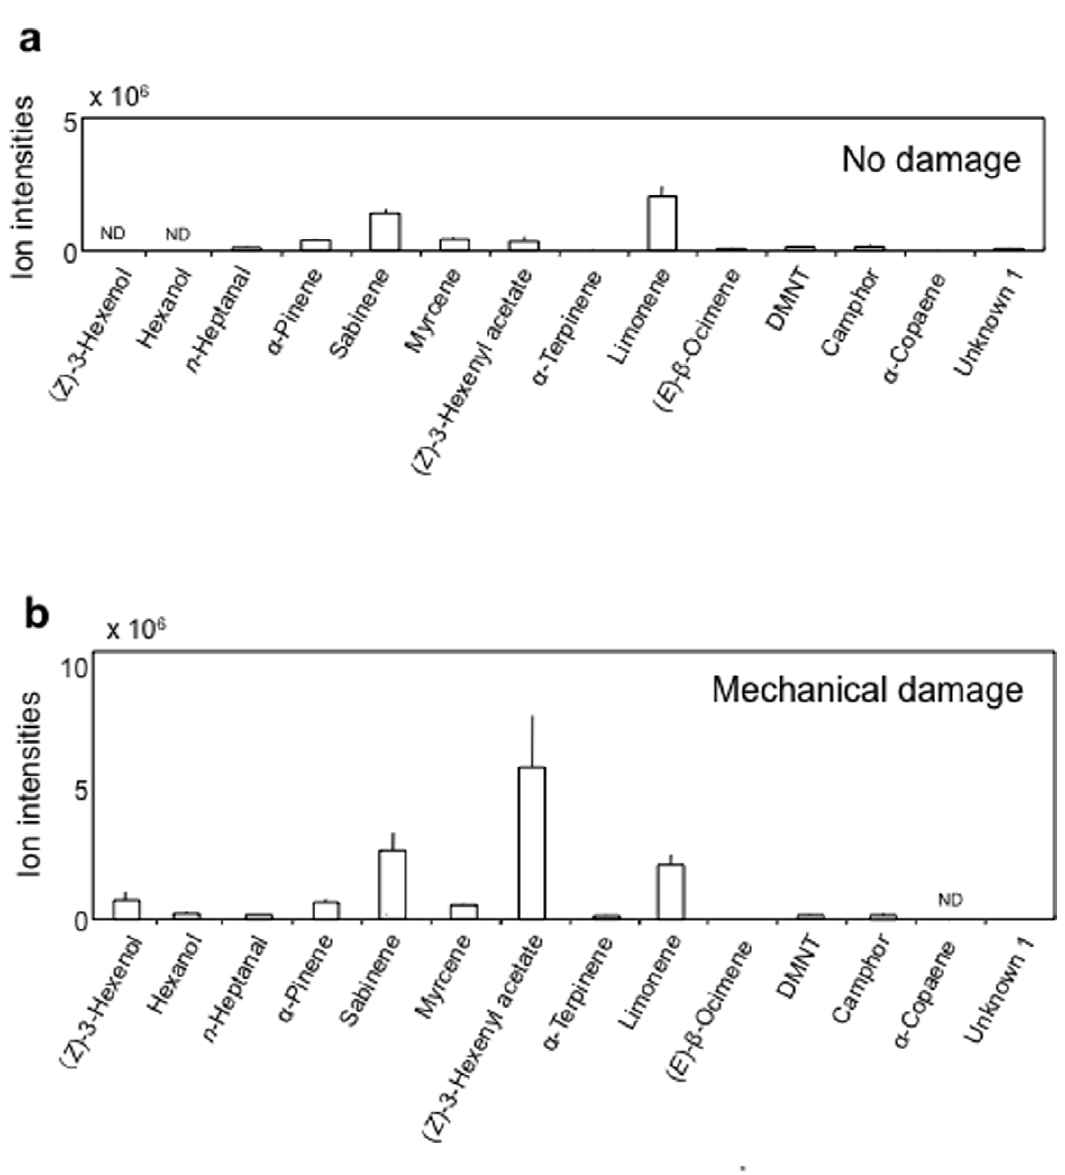
Figure 2. GC-MS analysis of headspace volatiles from herbivore-free cabbage ( B.oleraceavarcapitata cv Shikidori). Plants had either no damage (2a), mechanical damage